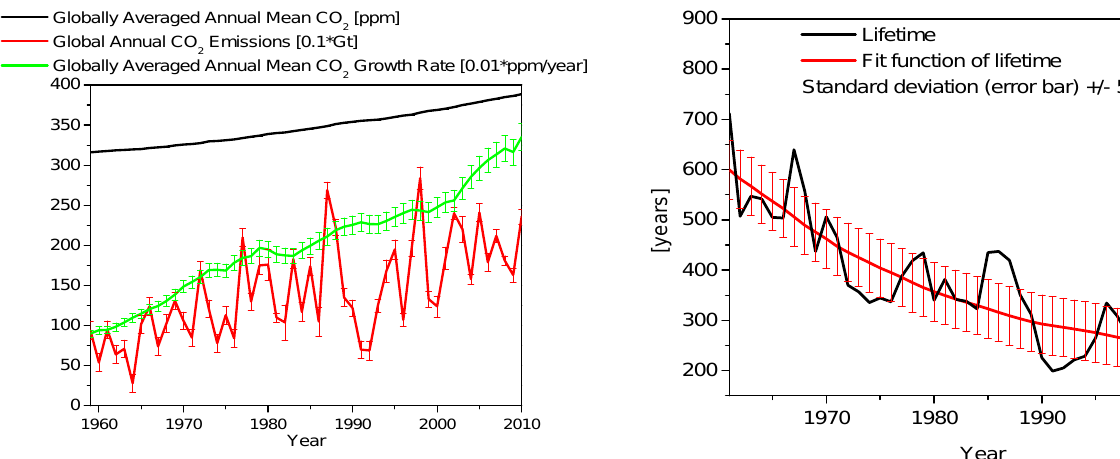
Fig. 2. Effective CO 2 lifetime in years derived (Eqs. 1 and 2) from the CO 2 records (black line) and the fitted curve of lifetime accord- ing to Eq. (3) (red line). The error bar represents the standard devi- ation of the lifetime from the fitted function of